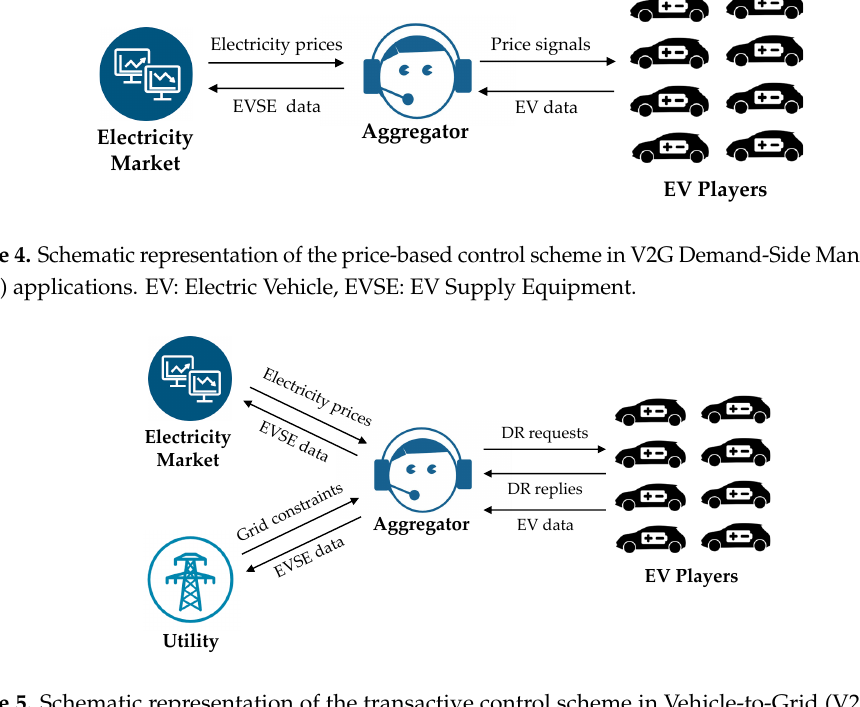
Figure 5. Schematic representation of the transactive control scheme in Vehicle-to-Grid (V2G) DSM applications. DR: Demand Response, EV: Electric Vehicle, EVSE: EV Supply